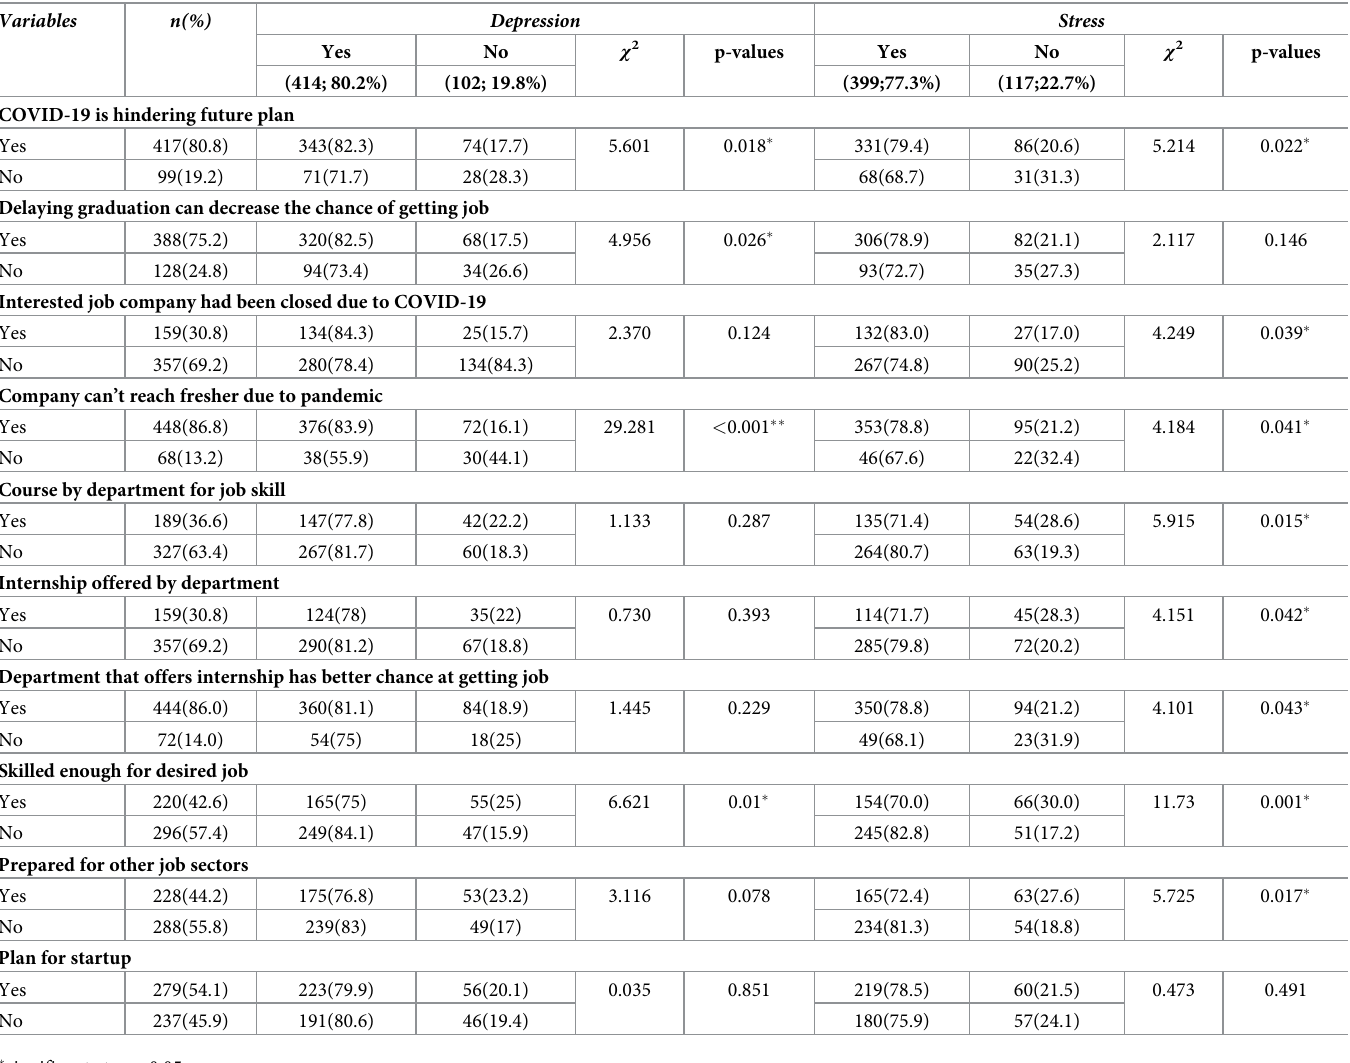
Table 3. Distribution of the future career related variables by depression and